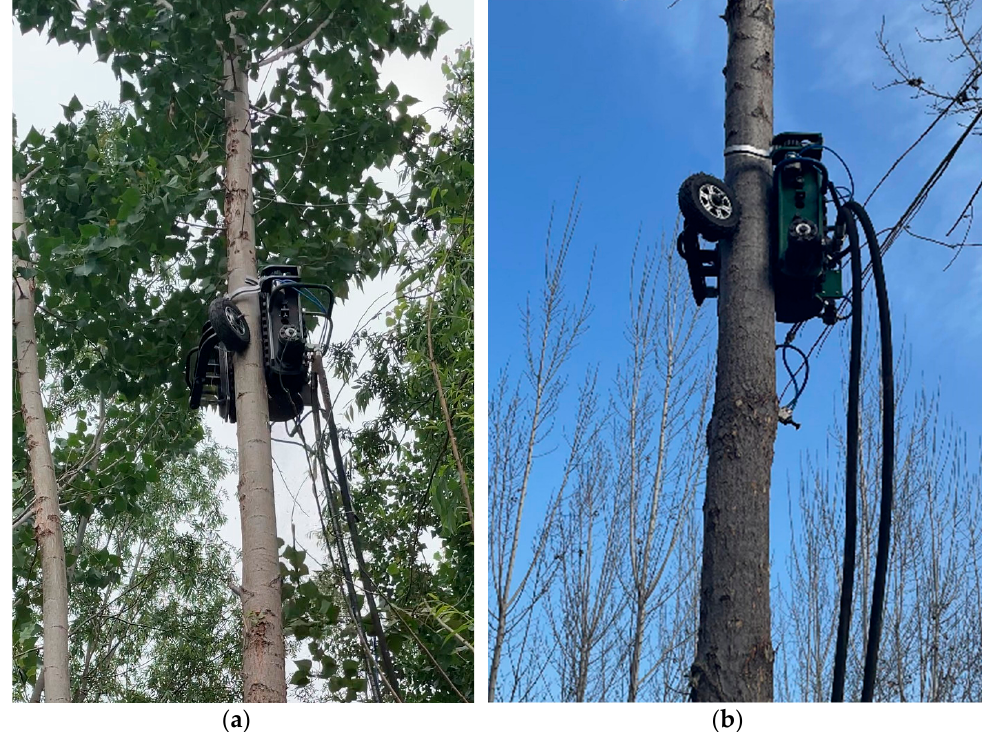
Figure 15. Forest test operations. ( a ) Late spring pruning; ( b ) winter pruning.